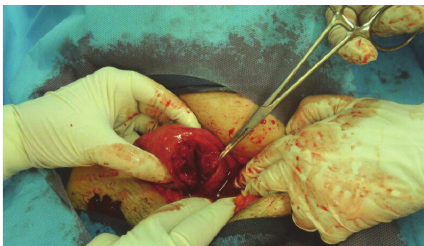
Figure 2: Rupture view of fundus up to cervix at the left side of the uterus in operation